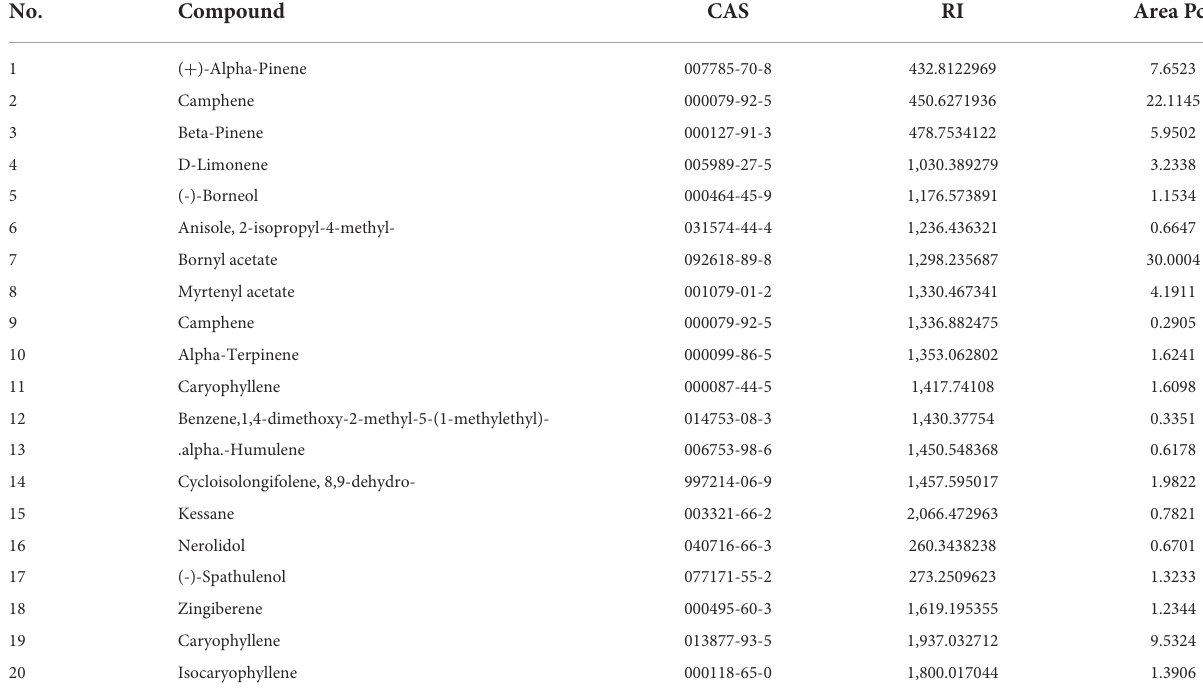
TABLE 2 Qualitative results of valerian essential oil by